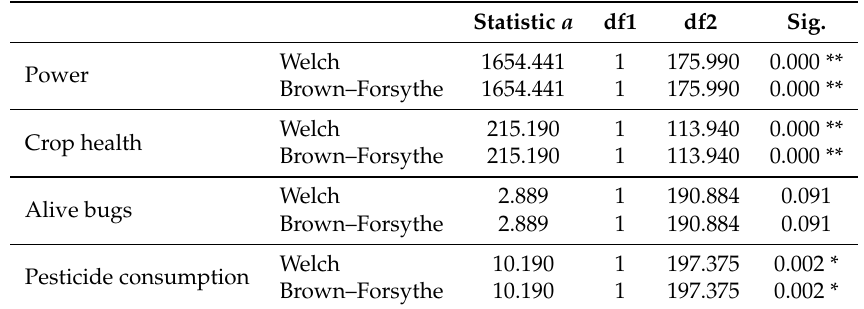
Table 4. Robust tests of the equality of means for comparing neighbor and low-cost neighbor strategies.